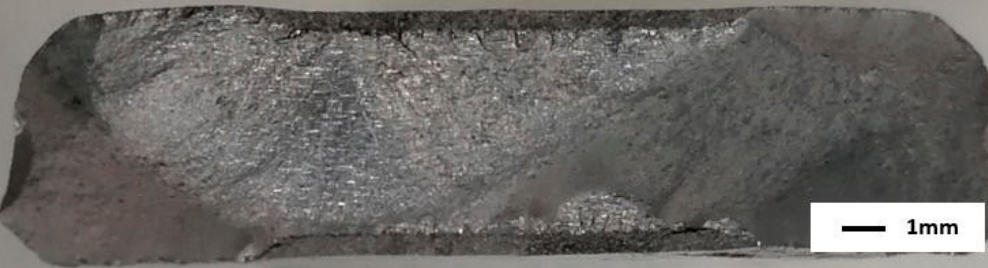
Figure 15. Failure surface associated with specimen 7075_F_3, failed at 83,590 cycles.